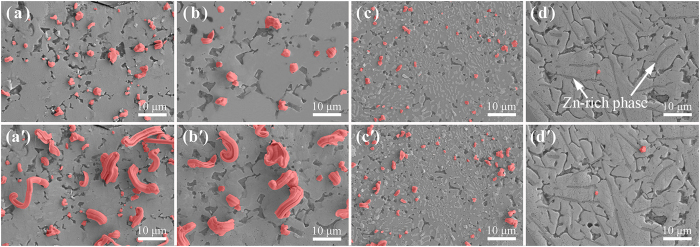
In situ observations of the surface evolutions for four types of Mg/Sn-based solder/Mg sandwich joints subjected to UAS at 250 °C for 6 s followed by thermal aging at 25 °C: (a) and (a’) SnAg3.5 aged for 0 and 7 d, respectively; (b) and (b’) SnCu0.7 aged for 0 and 7 d, respectively; (c) and (c’) SnPb37 aged for 0 and 7 d, respectively; (d) and (d’) SnZn9 aged for 0 and 7 d, respectively. Note that the Sn whiskers generated in the Sn fillers are highlighted in red.